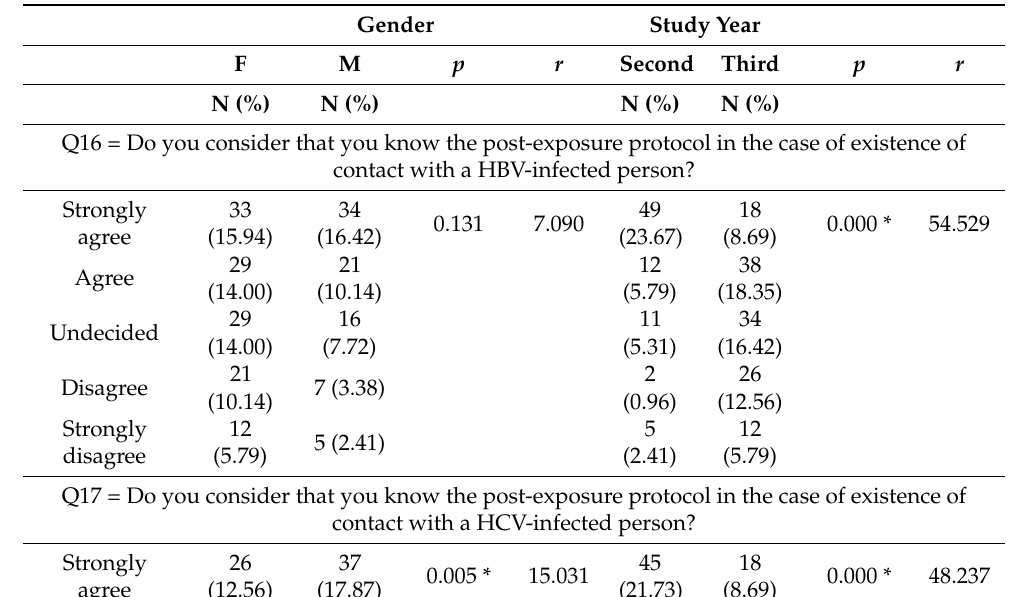
Table 4. Assessing the perception of the knowledge level regarding the accidental post-exposure protocol for HBV-, HCV-, and HIV-infected blood. Comparative data and Chi-square